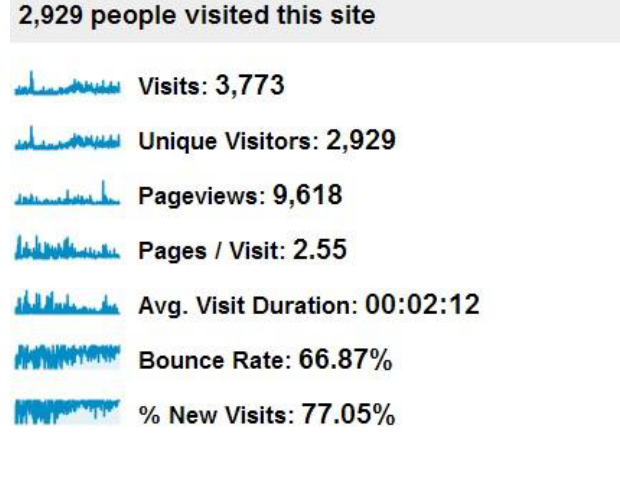
Figure 4. Quantity and frequency of the Start Strong website visits, 2010-2012, generated in Google